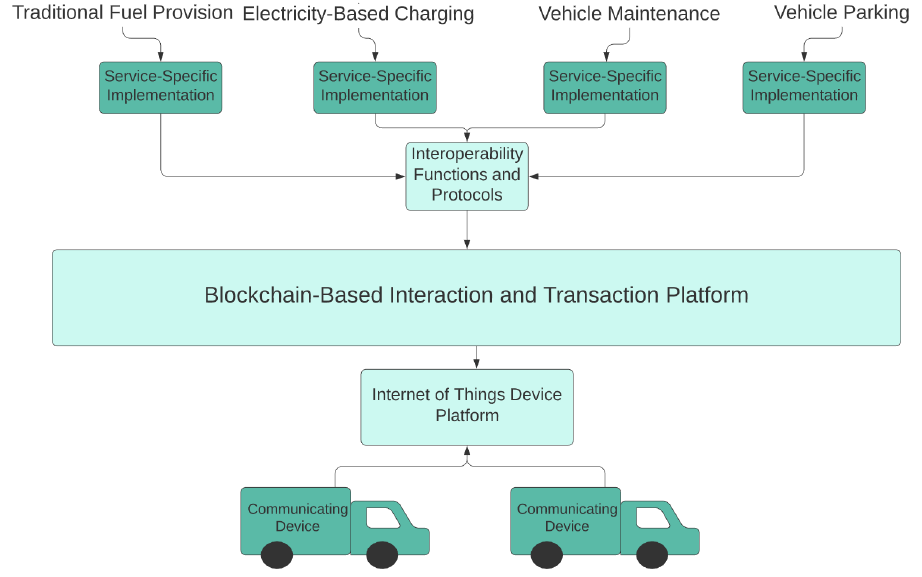
Figure 11. A model showing how transactions can be carried out and recorded through the use of blockchain in CAVs, inspired by